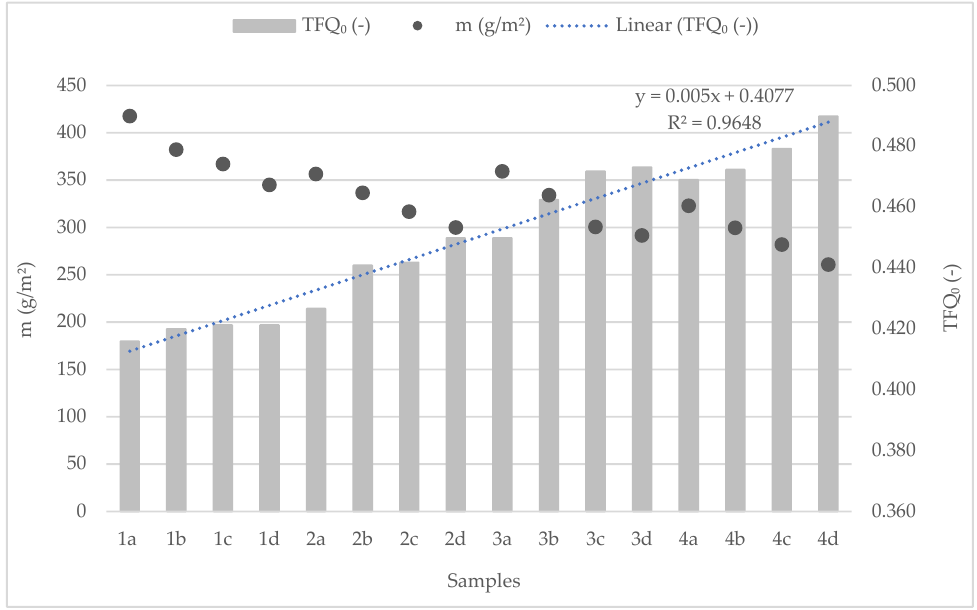
Figure 3. Heat transmission factor compared with woven fabric mass.